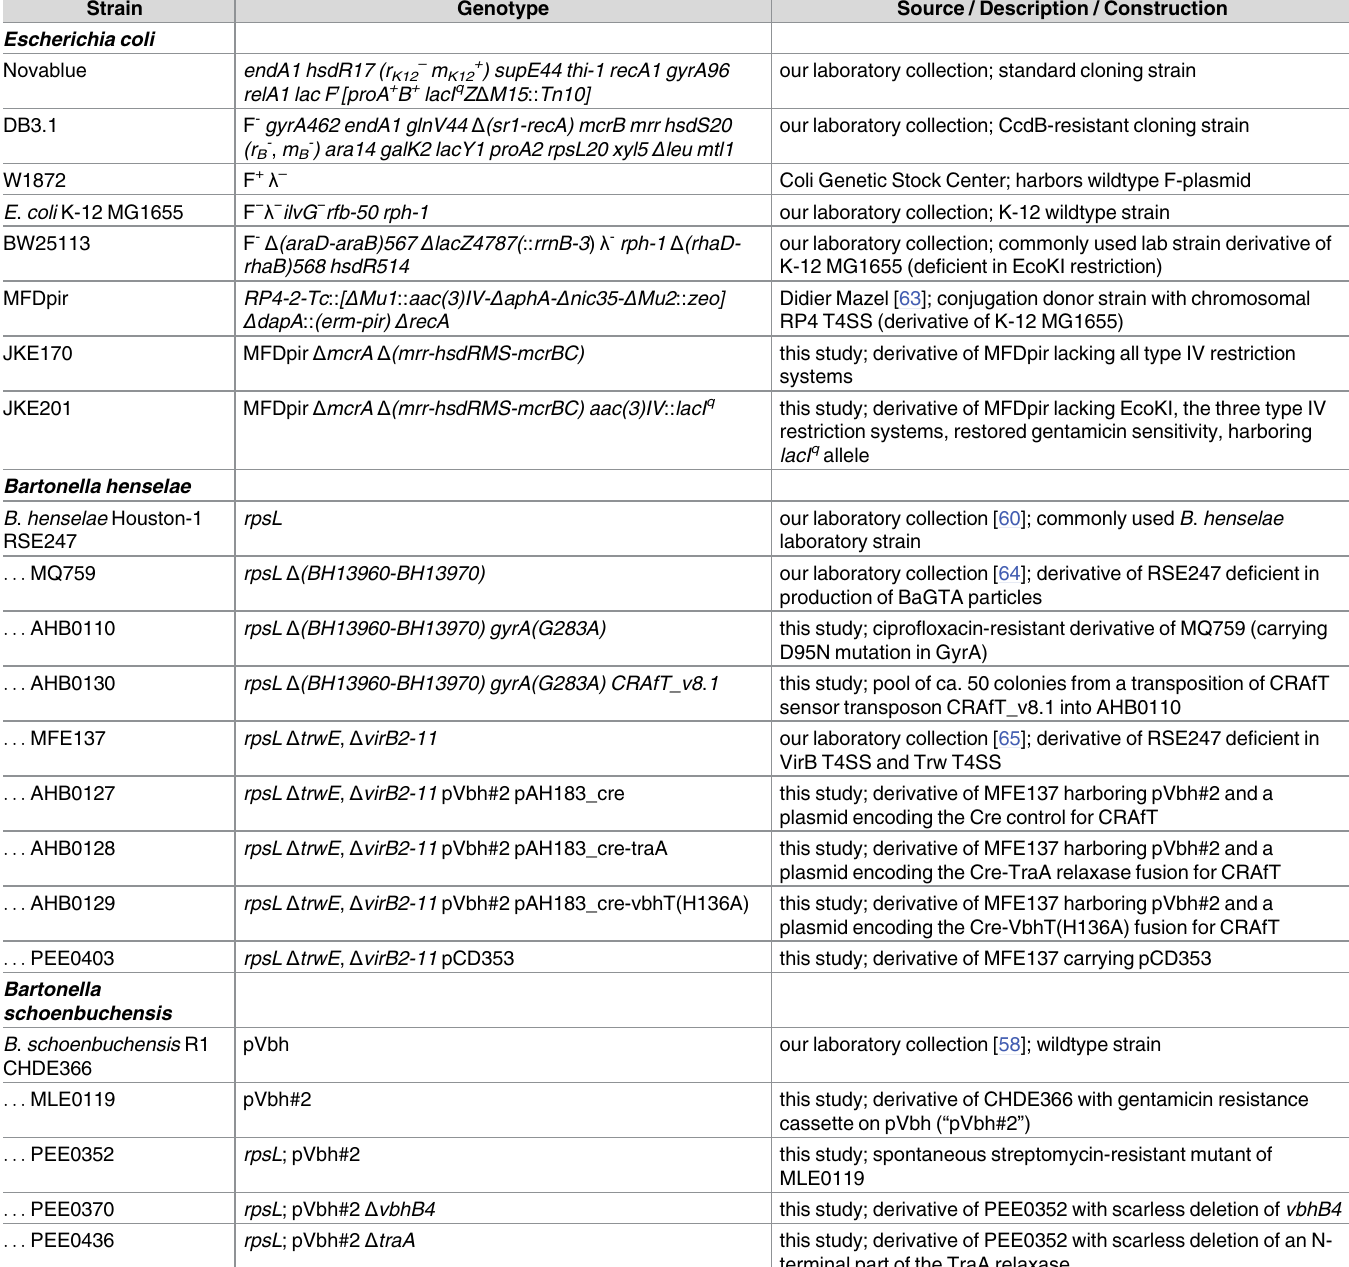
Table 1. List and construction of all bacterial strains of this study.